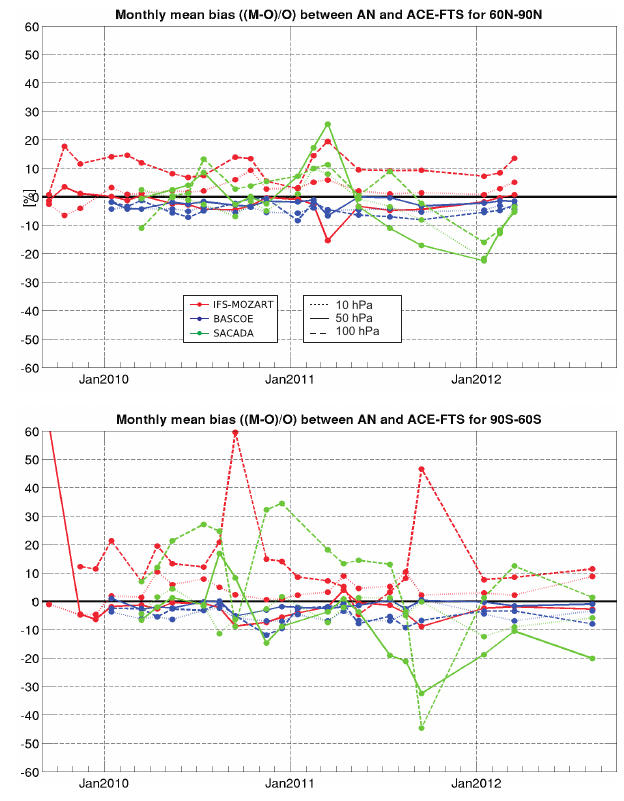
Figure 6. Comparison of the monthly mean relative ozone bi- ases between IFS-MOZART (red), BASCOE (blue), and SACADA (green) and ACE-FTS (analysis minus observations) in %, at 100 (dashed), 50 (full) and 10hPa (dotted) for the period September 2009 to September 2012 for the Arctic (top) and the Antarctic (bot-